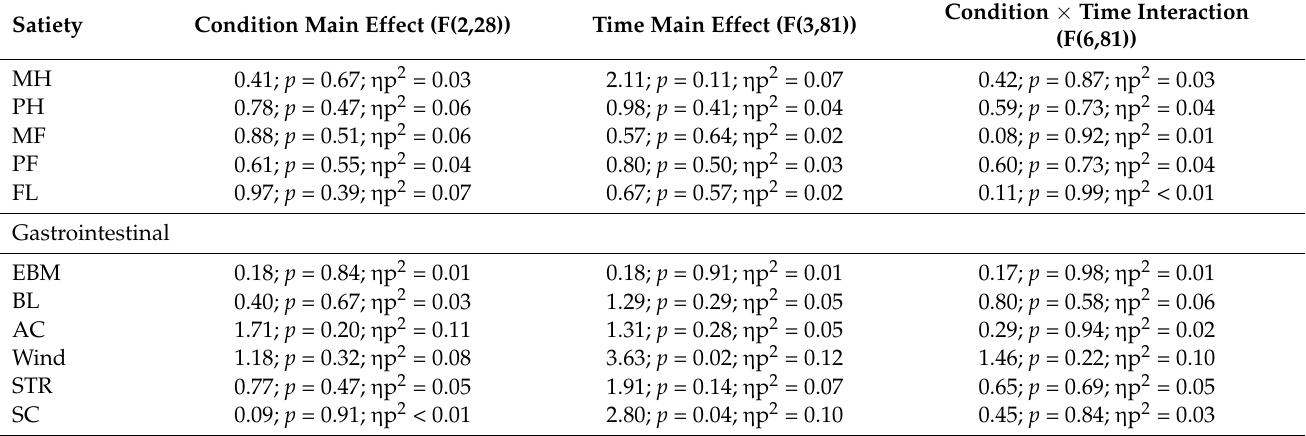
Table 2. Results of the repeated measures analysis of variance for the five satiety factors, namely mental hunger (MH), physical hunger (PH), mental fullness (MF), physical fullness (PF), and food liking (FL), and the gastrointestinal response (EBM = ease of bowel movement; BL = bloating; AC = abdominal cramping; Wind = breaking or passing wind; STR = stomach rumbling (borborygmi); SC = stool